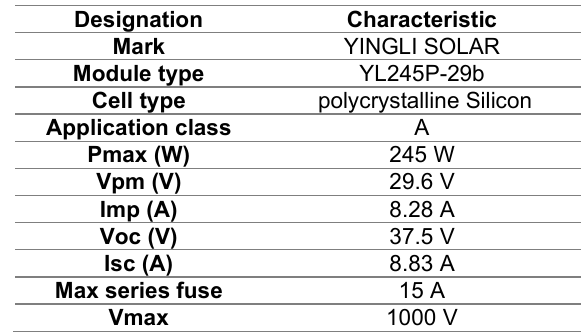
Table 8. Panel technical specifications